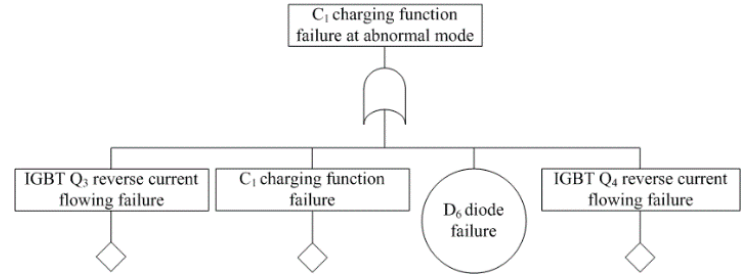
Figure 7. Sub fault tree for C 2 charging function failure at normal mode.